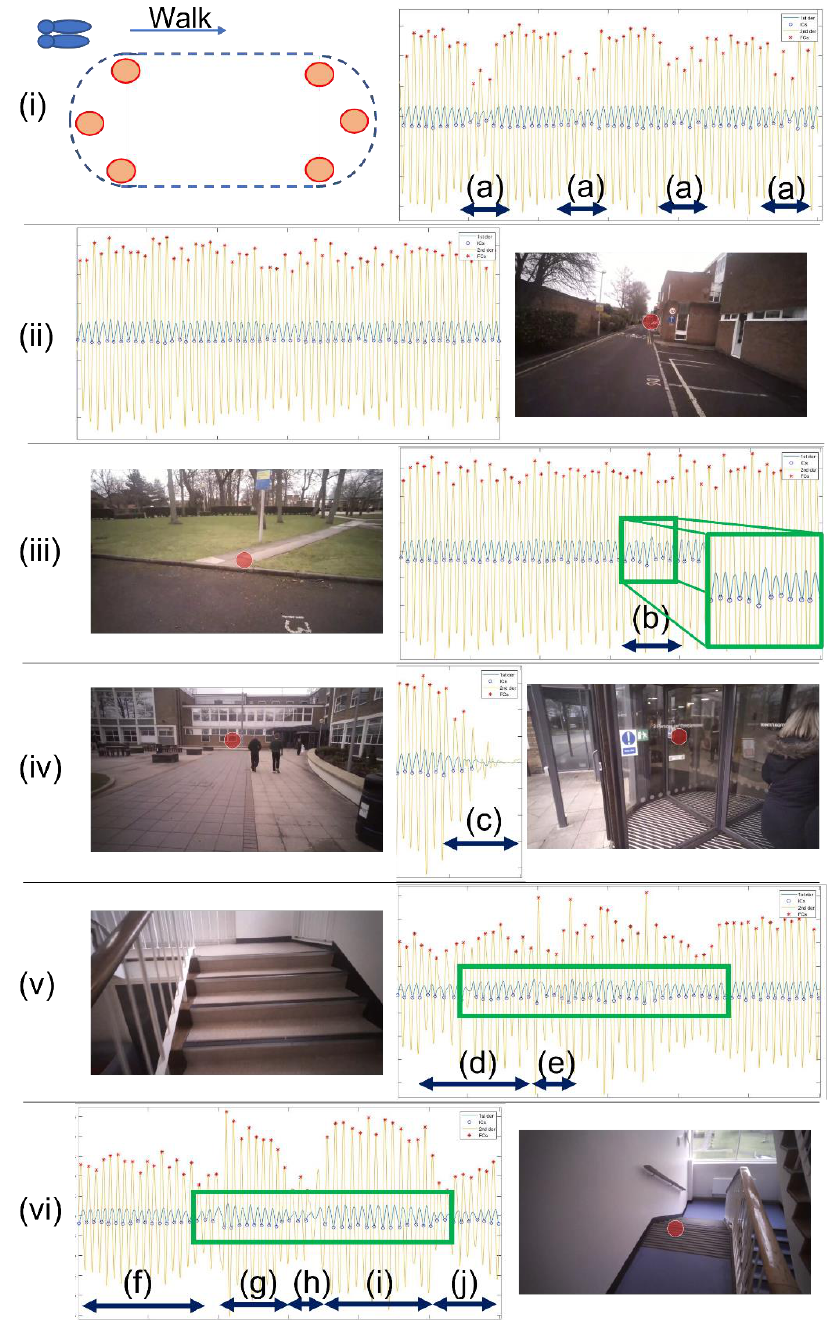
Figure 4. Walking bout IMU processed and video data. ( i ) 30 s (from continuous 2 min loop) within a lab, (a) denoting the turns at the end of the track, ( ii ) level walking on asphalt with no clear abnormality in the IMU data but walking was in a linear path (i.e., straight line), ( iii ) walk from asphalt to paving and a step identified by the participant (red dot), with a possible anomaly in IMU-based data from visual observation denoted by (b and green squares), which roughly equates to the time of a single step from asphalt to paving, ( iv ) walking on paving and (c) at the latter stages of the 30 s walk as the participant stops before entering a revolving door, ( v ) stair ascent, noticeable changes in the CWT-based data as the participant walks up steps (d) and turns left (e) on the landing, and ( vi ) noticeable changes in the CWT-based data from level walking (f), stair descent (g), short steps to turn to next flight (h), stair descent (i) and level walking (j). The green rectangle in ( v , vi ) highlighting the similar fluctuations, as observed in ( iii ), due to